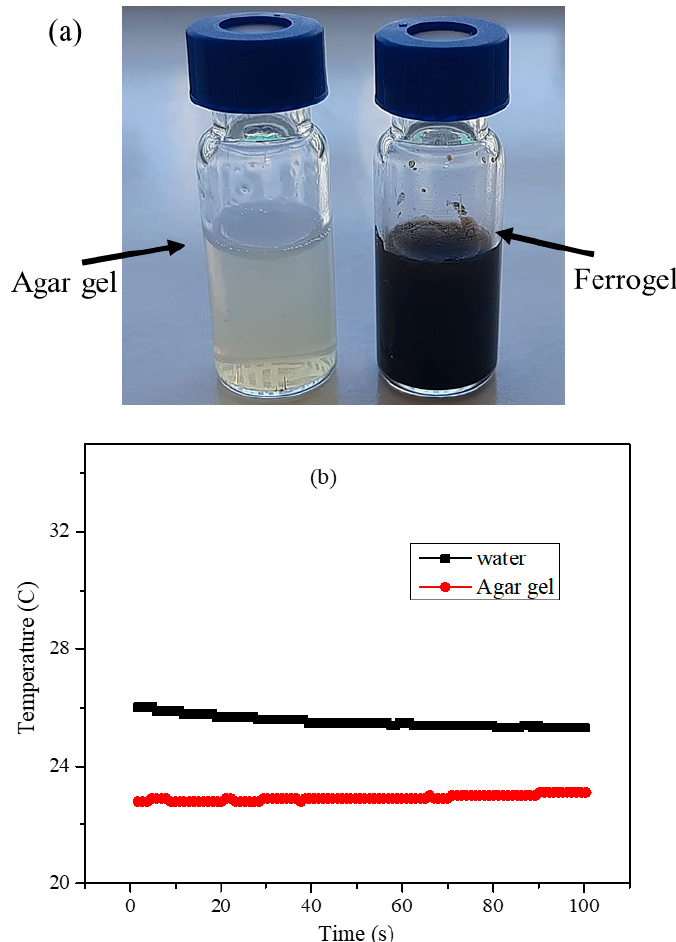
Figure 10. ( a ) Images of agar gel and ferrogel of the nanoparticles used for hyperthermia measure- ments. ( b ) Heating profiles of 1 mL of distilled water and agar gel.